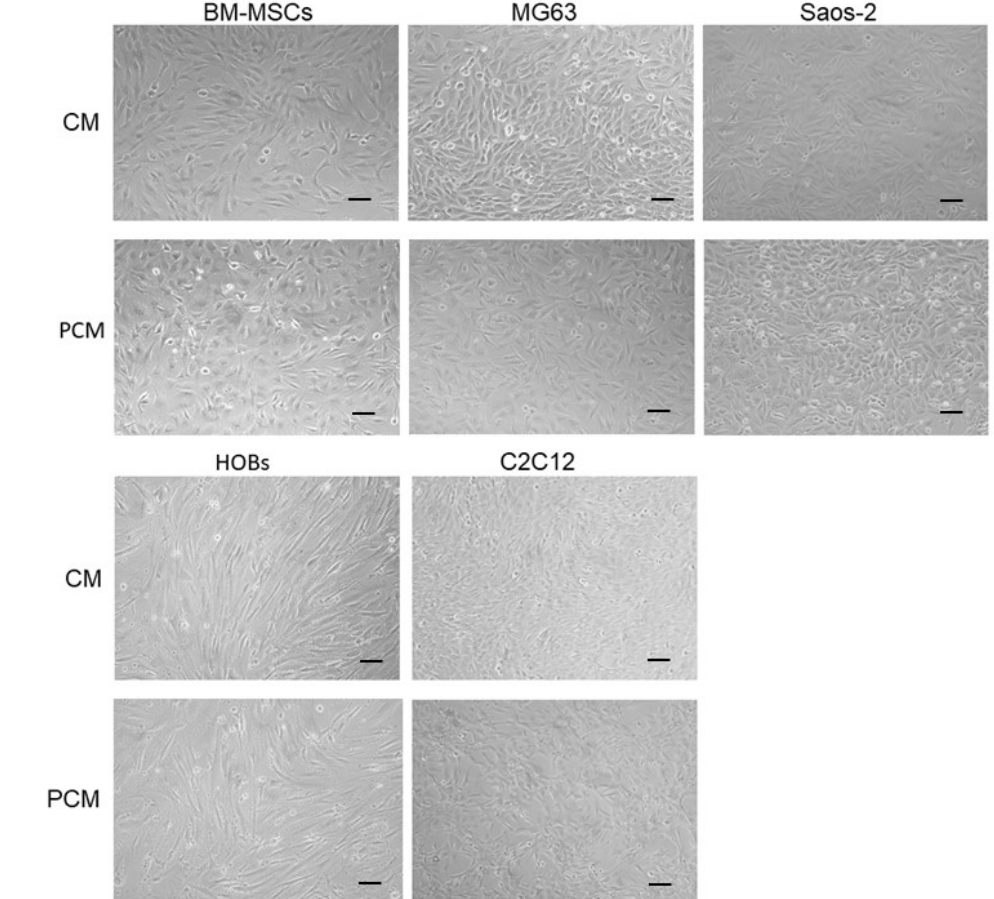
Figure 3. This figure shows phase-contrast images of BM-MSC, MG63, Saos-2, HOBs and C2C12 cell cultures after a24 h incubation with CM or PCM. Scale bars = 100 µm.